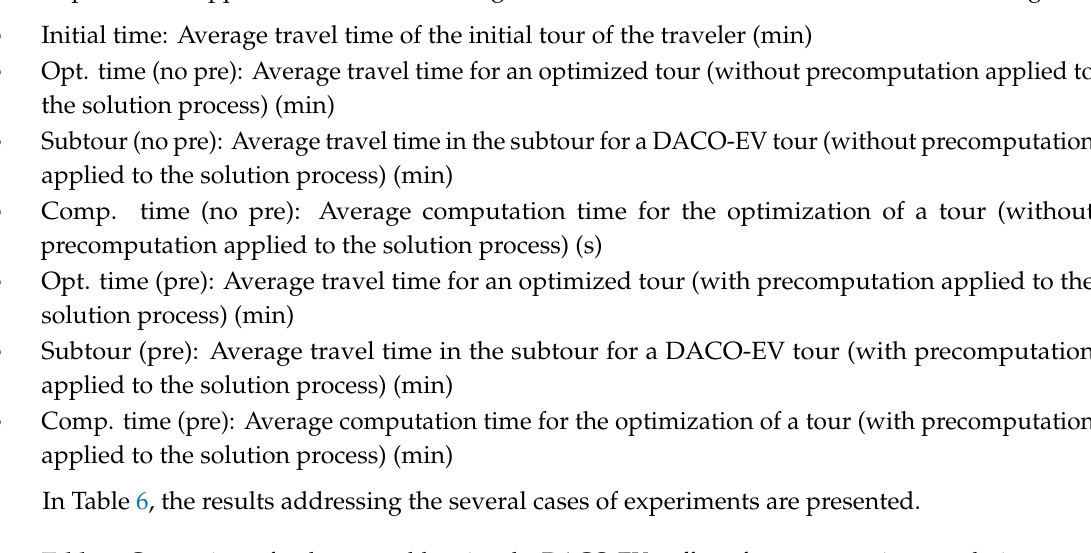
Table 6. Comparisons for the runs addressing the DACO-EV—e ff ect of precomputation on solutions and computation